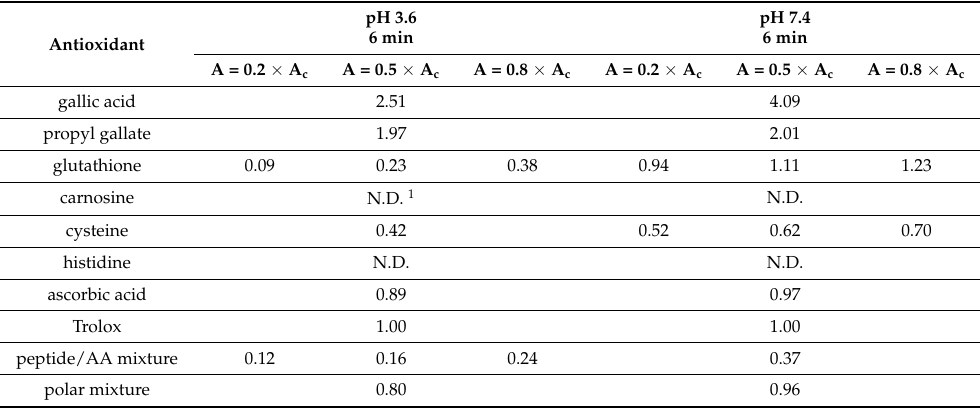
Table 10. TEAC values determined against ABTS radical cations applied in buffers (radical solution diluted with ethanol) after standard reaction